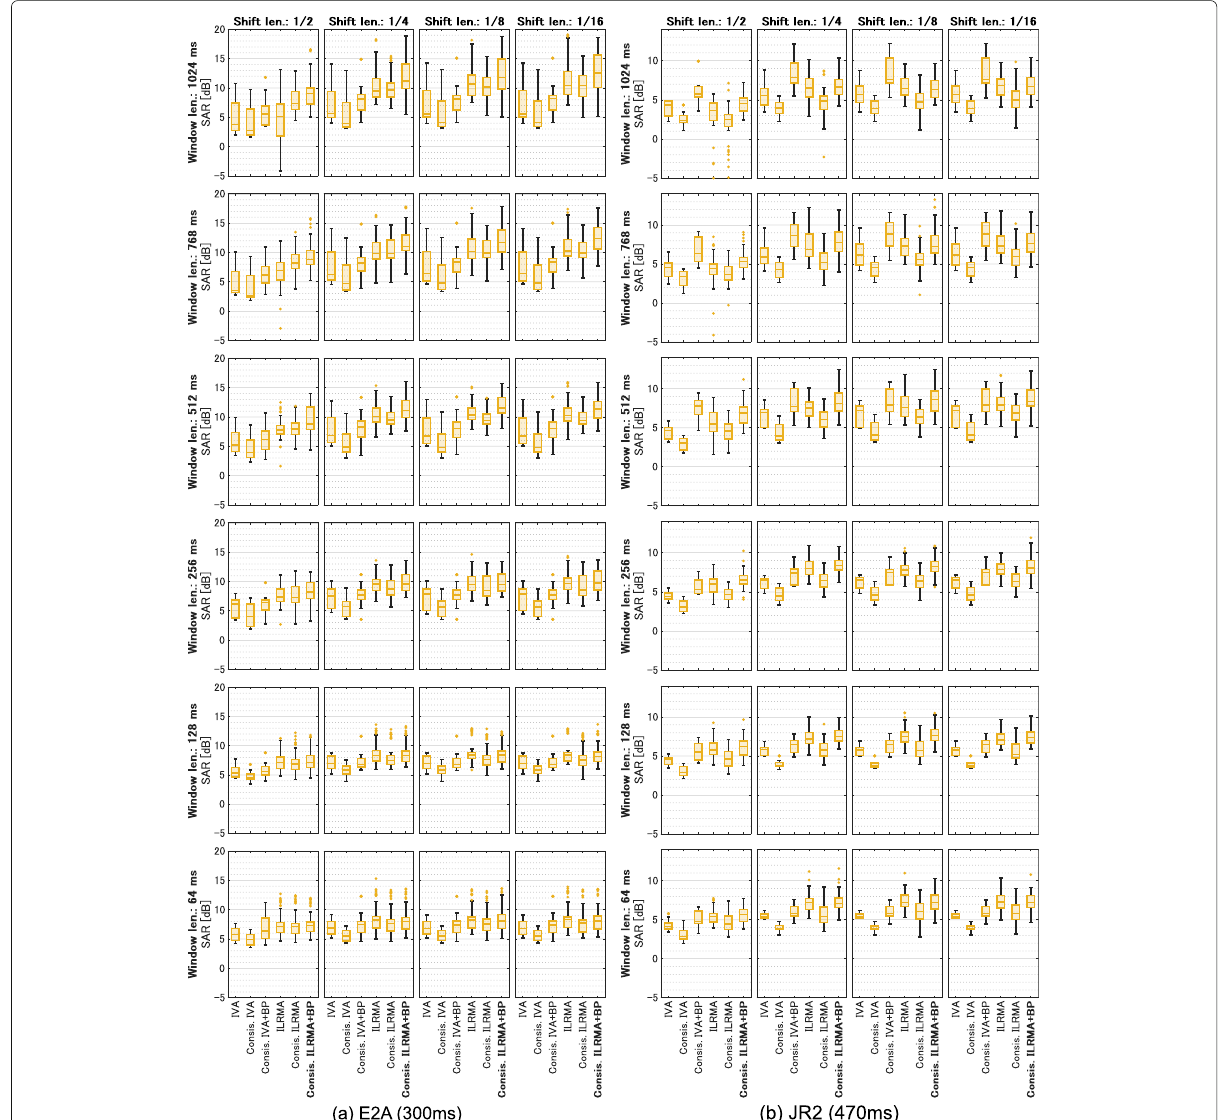
Fig. 27 Average SAR for synthesized speech mixtures (speech 1–10) with a E2A and b JR2 , where Blackman window is used in